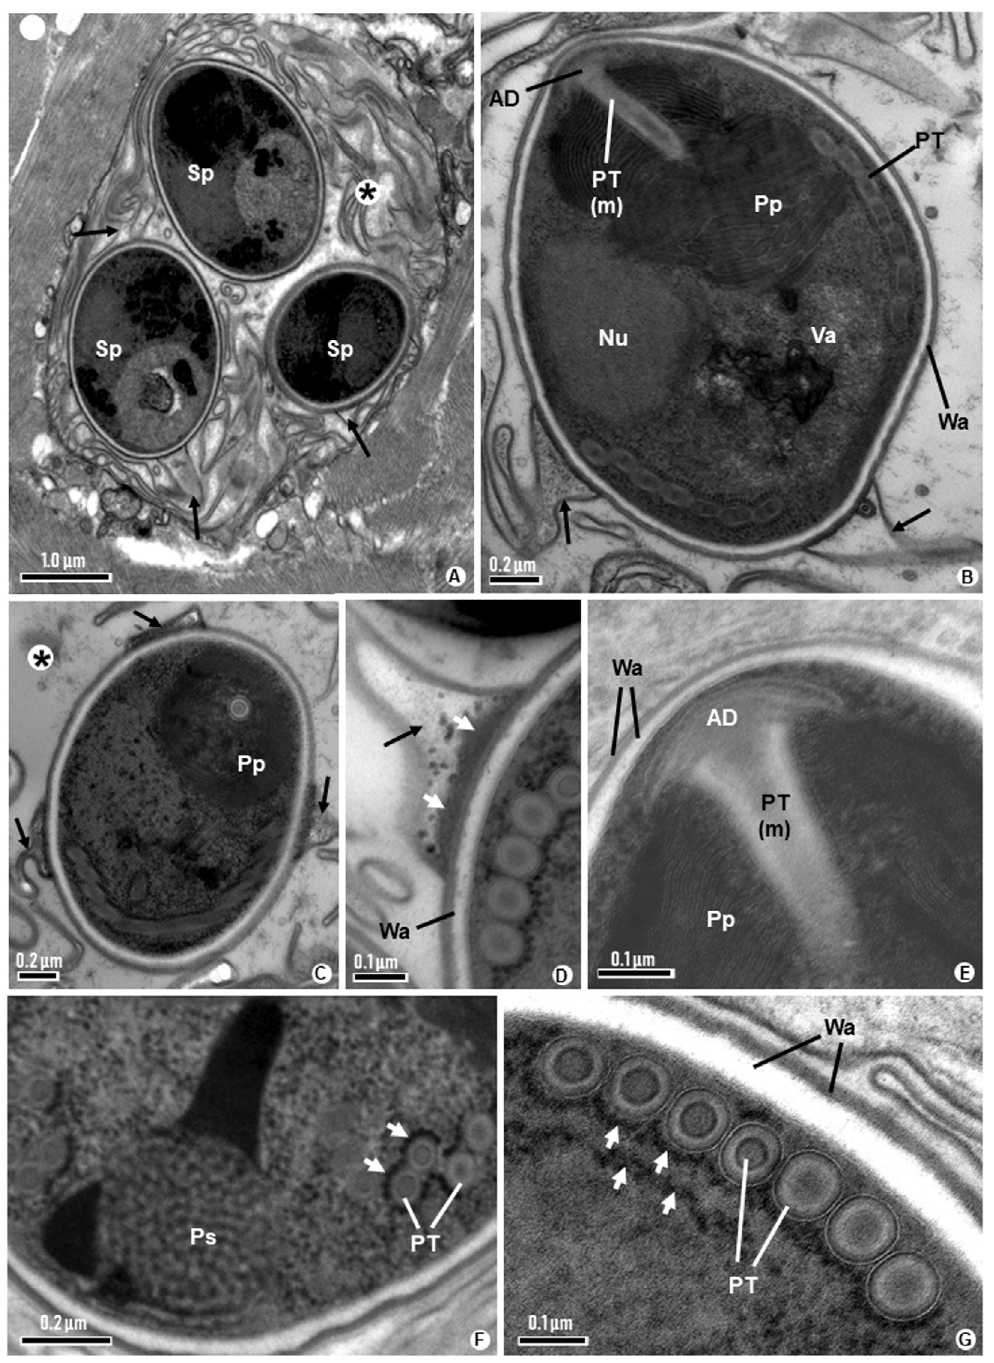
Figure 3. Ultrastructure of spores of Inodosporus sp. ( A ) Sporophorous vacuole (*) surrounded by muscle fibers, showing three spores (Sp), each surrounded by a complex membranous system, and tape-like filaments (arrows). ( B ) Longitudinal section through the spore showing the principal organelles and structures of the spore: spore wall (Wa), tape-like filaments (arrows), anchoring disc (AD) in continuity with the manubrial part of the polar tube (PT-m) and the polar tube coils (PT). The anterior portion of PT is enclosed by the polaroplast. Nucleus (Nu) and posterior vacuole (Va) are also in view. ( C ) Electron dense zones, to which appendages are attached, are located on the spore wall and indicated by arrows. ( D ) Zone of attachment (white arrows) of the tape- like filaments (black arrow) to the spore wall (Wa). ( E ) Apical region of the spore showing the spore wall (Wa), anchoring disc (AD), the manubrial portion of the polar tube (PT-m) and polaroplast (Pp). ( F ) Detail of the basal region of the spore showing the spore wall, the posterosome (Ps) and polar tube coils (PT) surrounded by several ribosome-like structures (white arrows). ( G ) Transverse sections of the polar tube (PT), located near the spore wall (Wa), showing adherent ribosome-like structures (white arrows). The transverse sections through the polar tube coils reveal variable